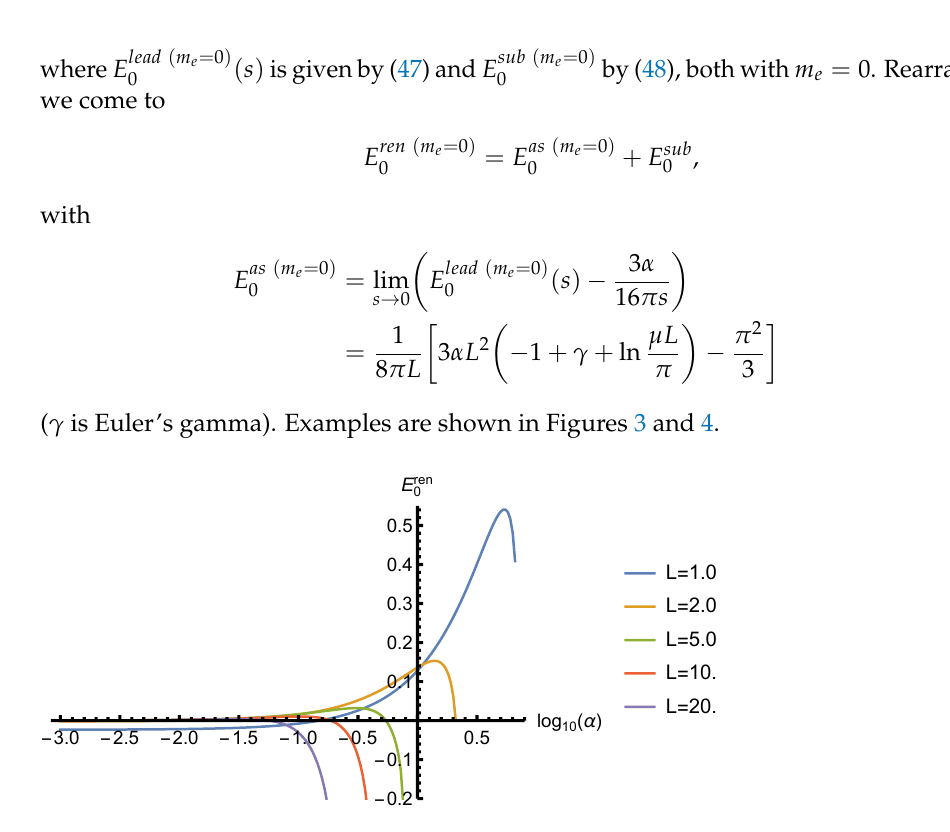
Figure 2. The vacuum energy E ren of a massive scalar field in a box with attractive self-interaction 0 with m e = 1. The curves terminate where the energy becomes complex. All quantities are given in units of the mass m e .